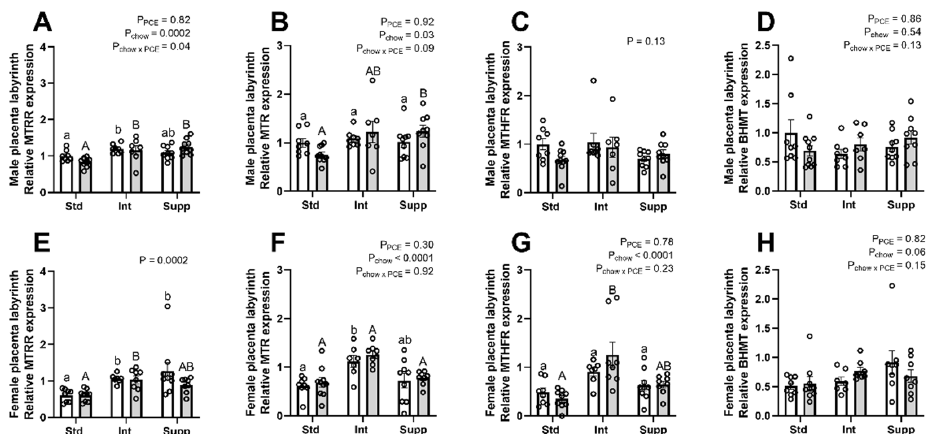
Figure 5. The effects of periconceptional ethanol and maternal choline supplementation on expression of key enzymes of one-carbon metabolism in placentas of male ( A – D ) and female ( E – H ) fetuses. Mtrr (methionine synthase reductase); ( B , F ) Mtr (methionine synthase); ( C , G ) Mthfr (5–10 methylenetetrahydrofolate reductase); ( D , H ) Bhmt (betaine homocysteine methyl transferase). During the periconceptional period, dams received a control liquid diet (Con; open bars) or a liquid diet containing 12.5% v / v ethanol (PCE; grey bars). For the remainder of pregnancy, dams received either standard chow (Std), intermediate chow (Int), or supplemented chow (Supp), with increasing levels of choline across these groups (1.6 g, 2.6 g, or 7.2 g choline/kg chow), n = 7–10 per group. Gene expression was analyzed relative to the geometric mean of Actb and RPL19 , with fold-change relative to the male Std-Con group. All data are presented as mean ± SEM. Significant differences due to alcohol exposure or chow group were identified via two-way ANOVA and Tukey’s post hoc analysis for parametric data, and via the Kruskal–Wallis test across all 6 groups, and Dunn’s post hoc analysis for non-parametric data. Results of post hoc analysis of chow effects are shown by lower case letters for control groups; upper-case letters for alcohol exposure groups.